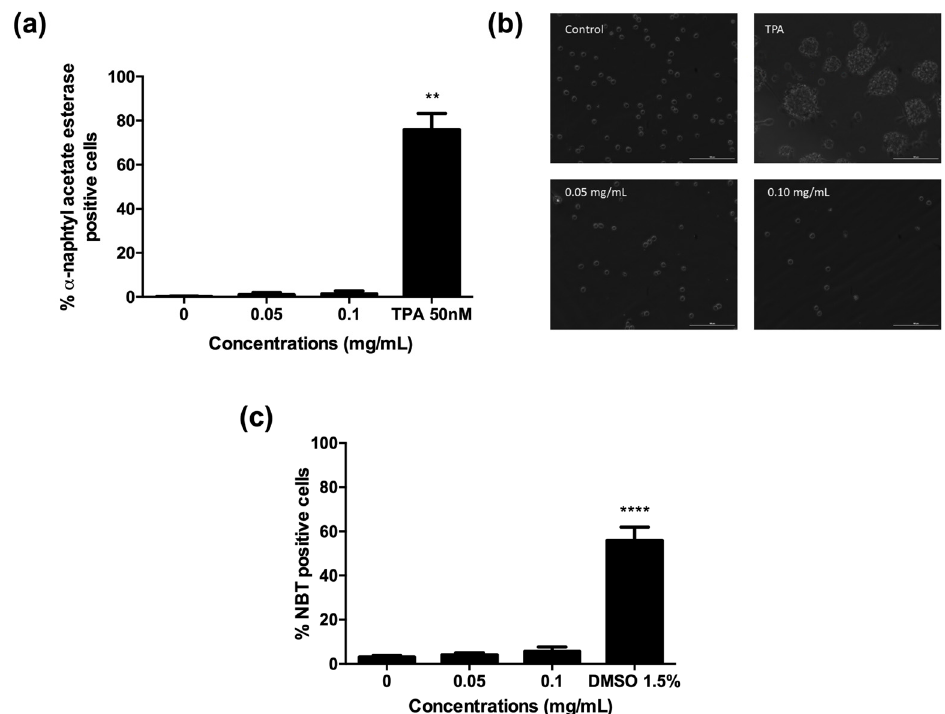
Figure 12. Effects of A. leucotrichus (0.05 and 0.1 mg/mL) on HL60 cell differentiation as analyzed by α -naphthyl acetate esterase activity ( a ); cell adhesion, magnitude 20x ( b ); NBT reducing activity ( c ). 12-O–tetradecanoylphorbol 13-acetate (TPA) and dimethyl sulfoxide (DMSO) were used as positive controls. ** p < 0.01; **** p < 0.0001 vs. untreated cultures (0).